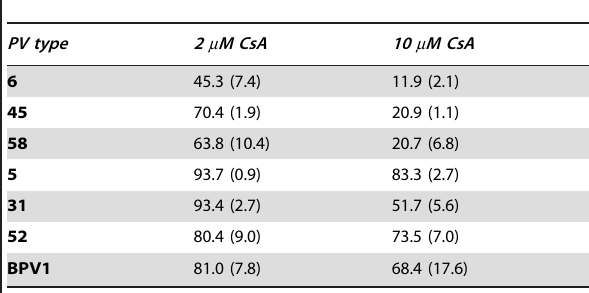
Table 1. Sensitivity of PV types to